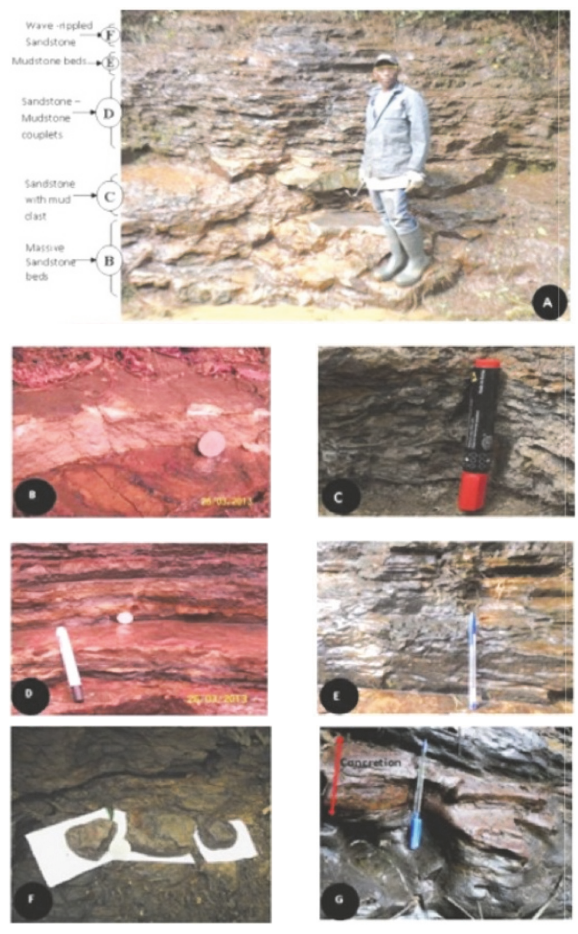
Figure 4: (A) The upper part of the Djega outcrop showing the frequently alternating beds of sandstones and mudstones. (B–F) show the various lithofacies of the upper part of the outcrop as indicated in (A). (G) A shale bed, iron stained, characteristic of the lower part of the Djega outcrop. (H) A bed of concretion, sometimes nodular frequently interbedding the shales.